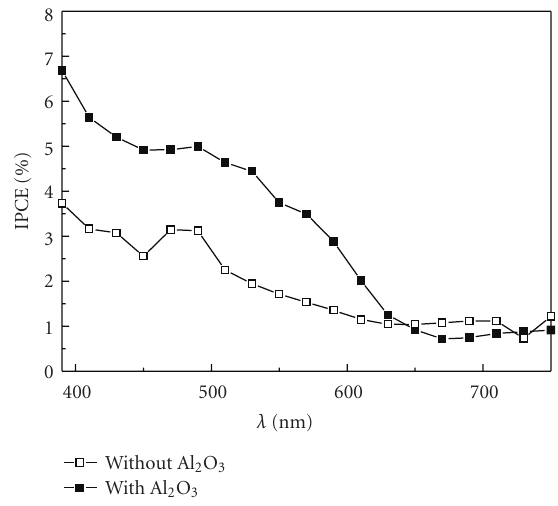
Figure 20: Photoaction spectra of a TiO 2 /Dye/PEDOP/Au cell (white squares) compared to a TiO 2 /Al 2 O 3 /Dye/PEDOP/Au system (black